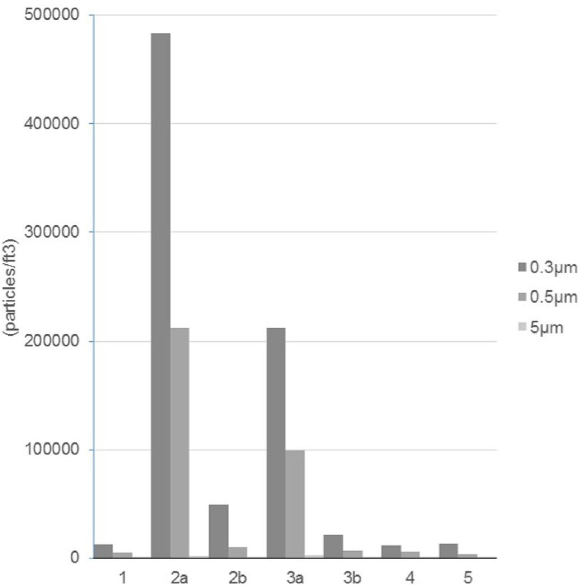
Figure 3. The variation in the average concentration of the PM. Horizontal axis: 1. Before the operation; 2a. Beginning of the operation in the main knife range; 2b. Beginning of the operation outside the operating table; 3a. After 5–10 min in the main knife range; 3b. After 5–10 min outside the operating table; 4. At the end of the operation; 5. Outside the operating room.